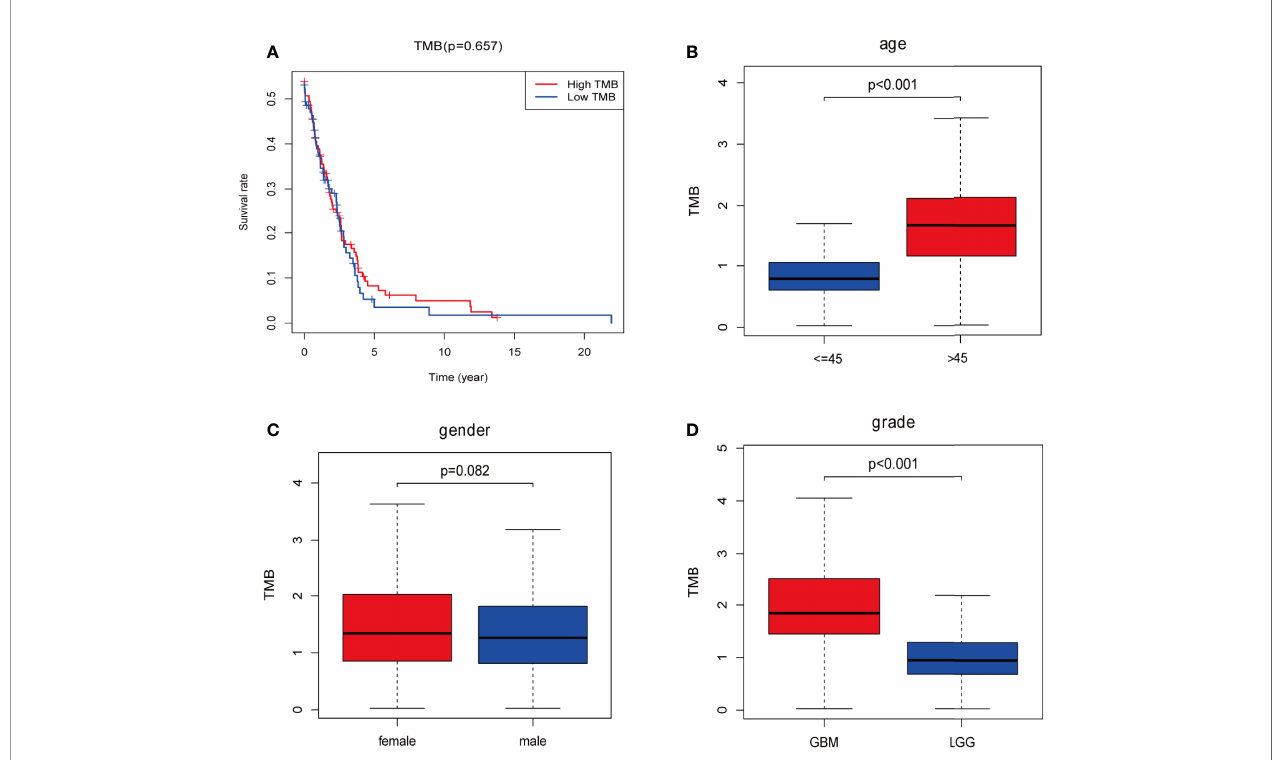
FIGURE 2 | Prognosis of tumor mutation burden (TMB) and associations with risk and clinical characteristics. (A) Higher TMB levels correlated with poor survival outcomes with P = 5.32e-07; (B, D) higher TMB level is associated with age > 45 years and higher tumor grades; (C) no signi fi cant differences were observed for gender. Red: high-TMB, blue: